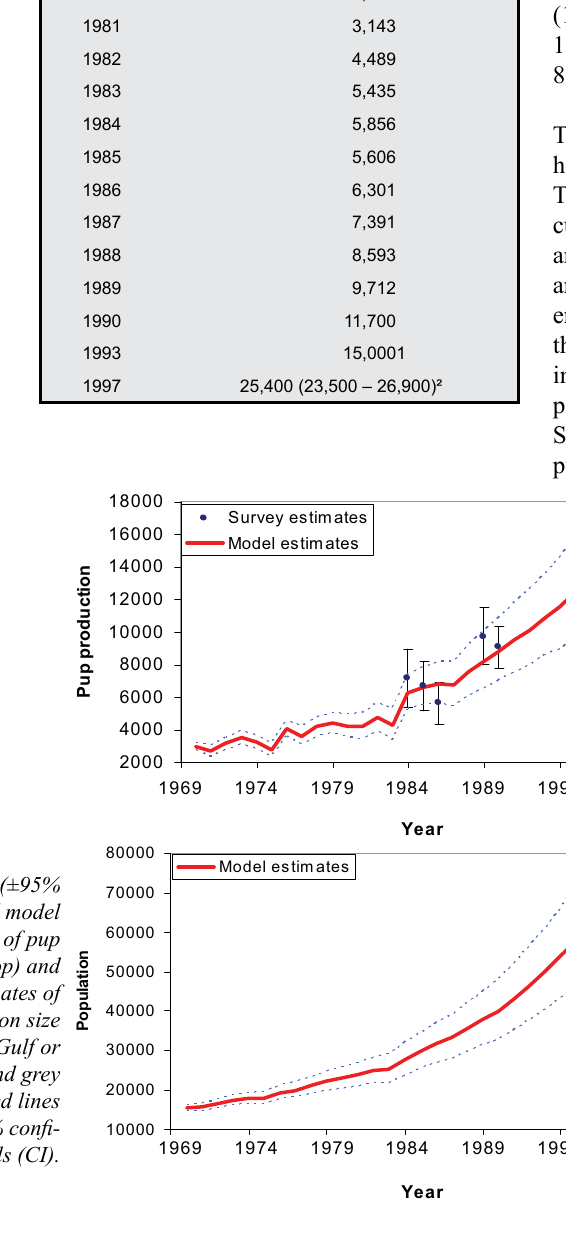
Fig. 6. Survey (±95% CI) and model